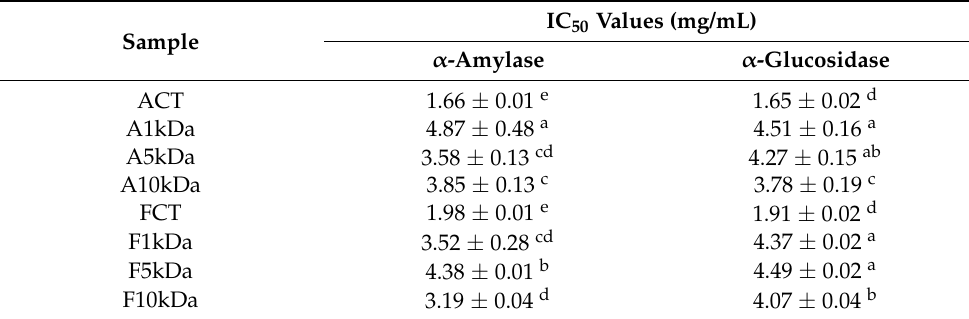
Table 1. IC 50 values of α -amylase and α -glucosidase inhibitory activities of lupin protein hydrolysates generated using alcalase, flavourzyme, and their ultrafiltrated